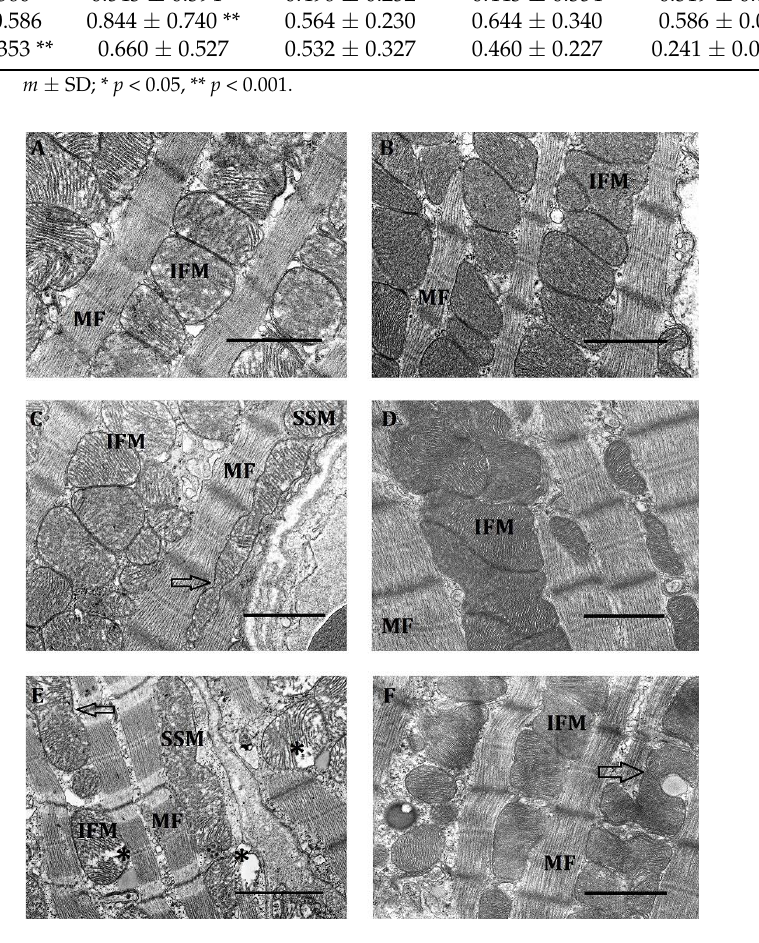
Figure 6. The ultrastructure of the intermyofibrillar region of a cardiomyocyte in rats with low ( A , C , E ) and high ( B , D , F ) resistance to oxygen deficit in mild (FiO 2 = 14%, ( A , B )), moderate (FiO 2 = 10%, ( C , D )) and severe (FiO 2 = 8%, ( E ,F)) hypoxia. Tissue samples were taken 30 min after the start of the respective hypoxic training. IFM, interfibrillar mitochondria; MF, myofibrils. Arrow—elongated interlocked mitochondria; asterics—lysed mitochondria. Scale bar, 0.5 µ